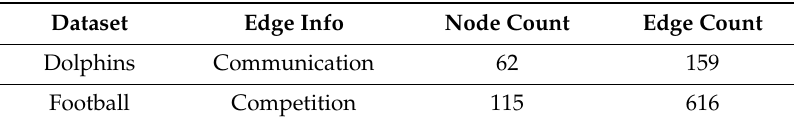
Table 1. Six di ff erent real